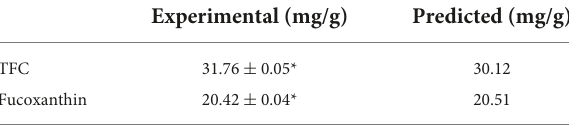
TABLE 4 Experimental and predicted values of responses by SC-CO 2 extraction 1 .